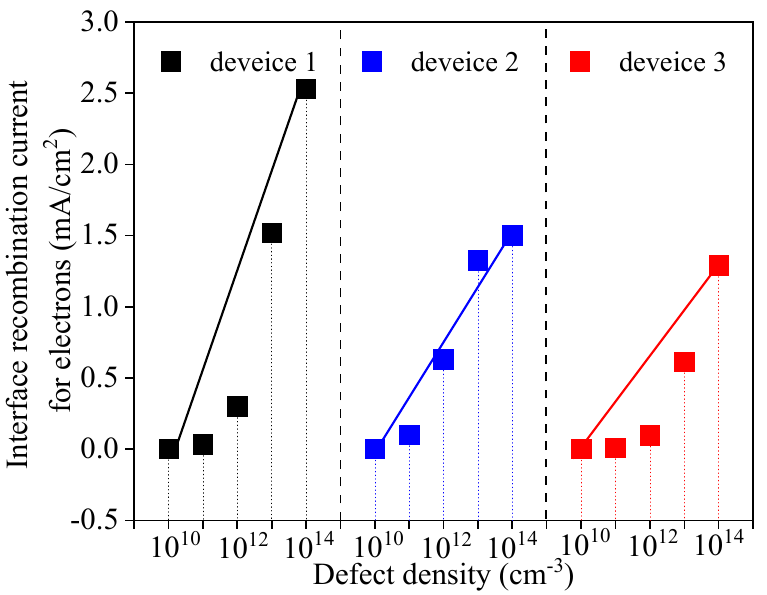
Figure 17. Effects of N it on the interface recombination current for electrons. Table 4 reveals that device 3 exhibits relatively small fluctuations in its cell perfor- mance as N it changes compared with device 1 and 2. When N it changes from 10 10 to 10 14 cm − 3 , PCE of device 1 decreases by 42.66%, while PCE of device 3 only decreases by 23.92%. Apparently, the performance of device 3 is more stable than that of device 1 and device 2. The reason may be that the carrier concentration of a single ETL device at the interface between the ETL and the active layer is higher, which would result in a higher recombination loss than that of the double ETL device. Figures 17 and 18 confirm this hypothesis. In Figure 17, the black solid line, blue solid line, and red solid line are the lines of the interface recombination currents for electrons when N it varies between 10 10 and 10 14 cm − 3 , respectively. It can be seen from Figure 17 that the black solid line has the greatest slope, while the red solid line has the least slope. In other words, the interface recombination current for the electrons in device 1 undergoes the most significant change, while the interface recombination current for electrons in device 3 experiences the slightest change. Moreover, the interface recombination current of device 3 is relatively lower than the current of the other two devices. In Figure 18, the red and blue lines represent the total recombination when N it is 10 10 and 10 14 cm − 3 , respectively. It can be clearly seen that the total recombination of device 3 is relatively low and the change in the total recombination of device 3 is quite minimal (the direct distance between the two black dotted lines is the shortest). This suggests that the performance of a single ETL device is more affected by the interface defect density than that of the double ETL device. The increase in the interface defect density, or the increase in the number of traps at the interface, would result in more recombination, which in turn leads to performance degradation. Therefore, compared with the single ETL device, the double ETL device has a higher tolerance for interface defect